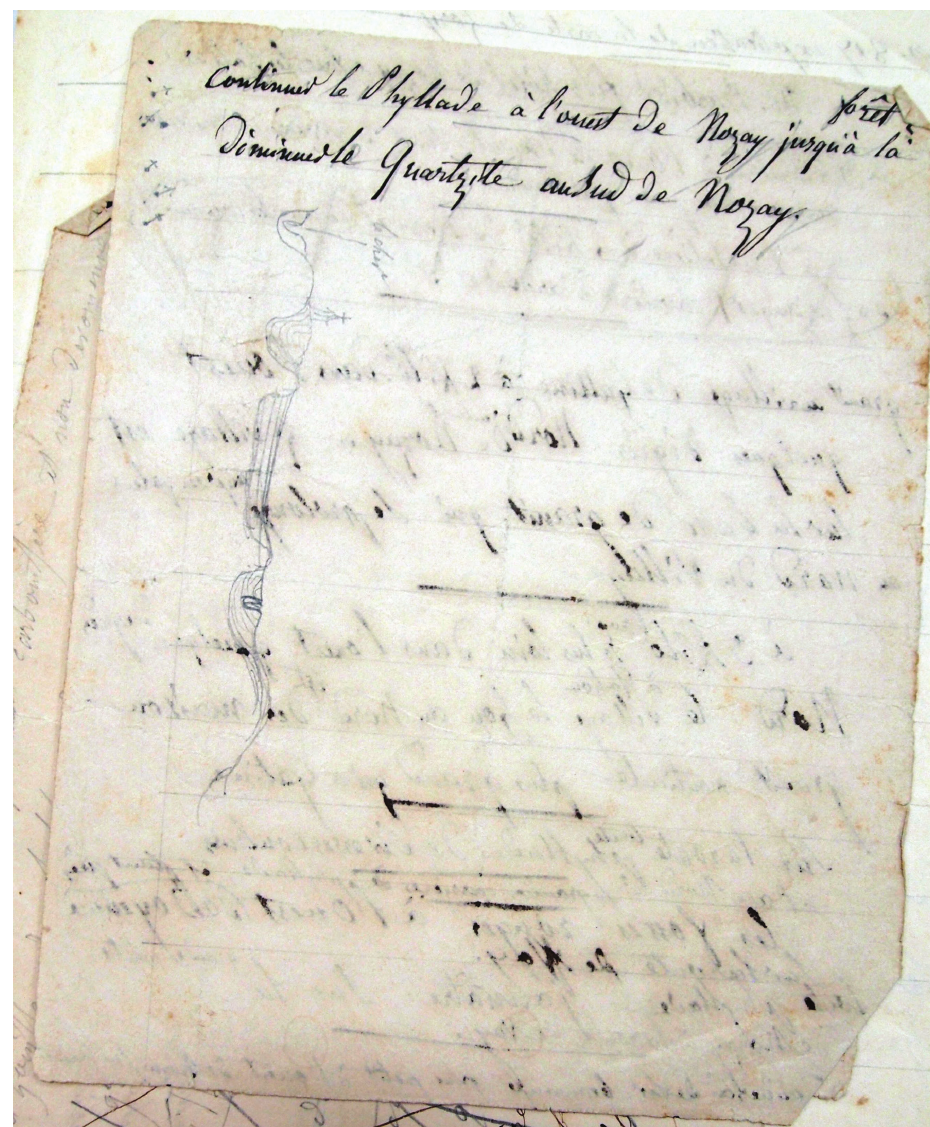
Figure 2: Textual and figurative representations of phyllites near Nozay. MNHH, 2R842, undated,